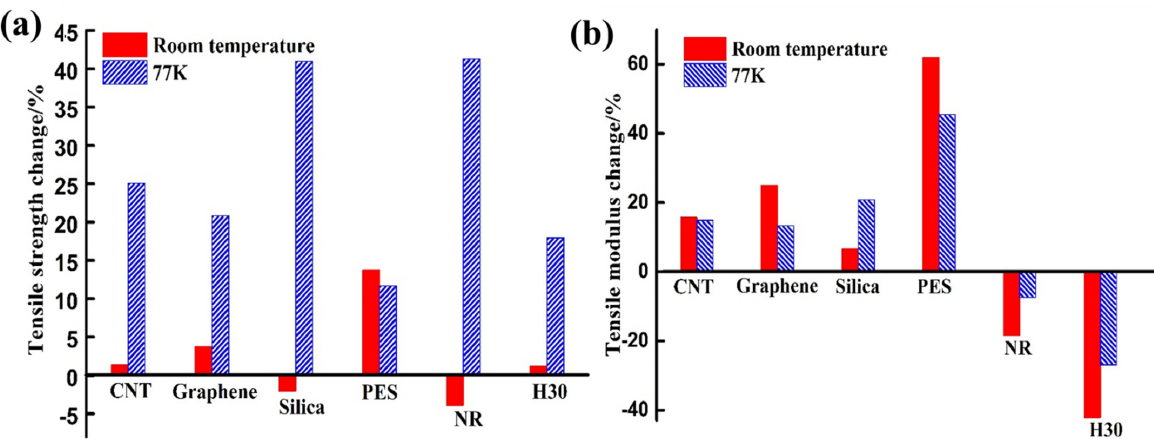
Figure 3. ( a ) The tensile strength and ( b ) tensile modulus change of CNT [37], graphene [40], silica [45], PES [48], NR [52] and H30 [55] modified polymer composites compared with unmodified polymers at room and cryogenic